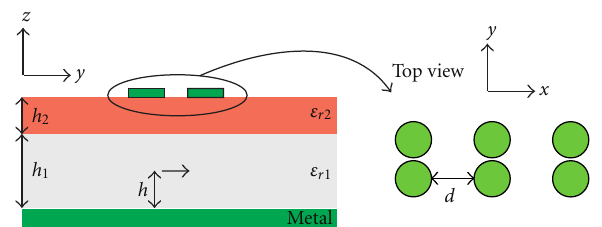
Figure 4: Multiple dimer configuration. The nanodisc dimer array can equivalently be replaced by an array of bowtie.